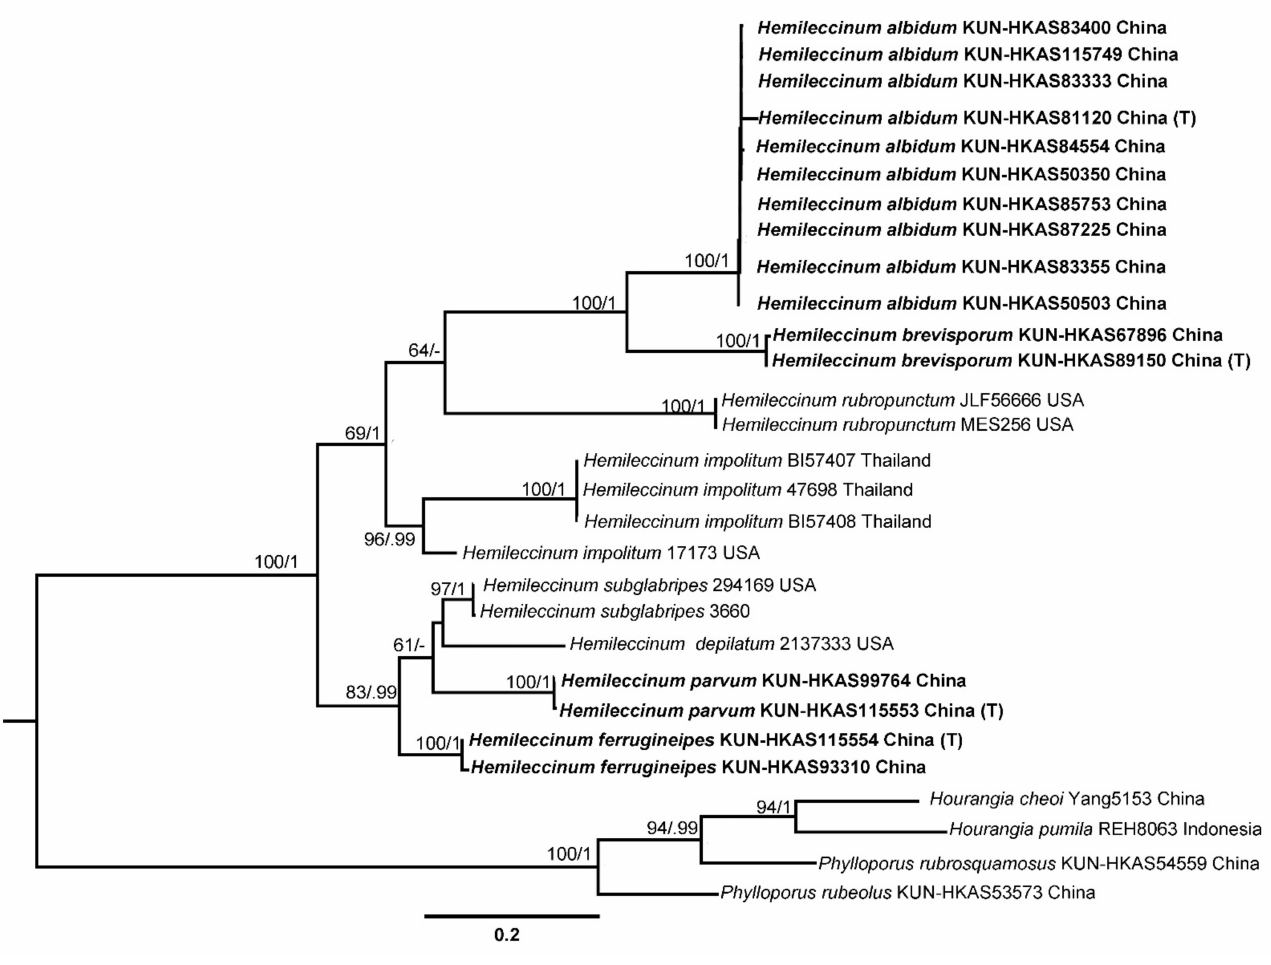
Figure 2. Maximum-Likelihood phylogenetic tree generated from ITS dataset. Bootstrap values (BP) ≥ 50% from ML analysis and Bayesian posterior probabilities (PP) ≥ 0.90 are shown on the branches. Newly described species are indicated in bold and their type specimens are marked with